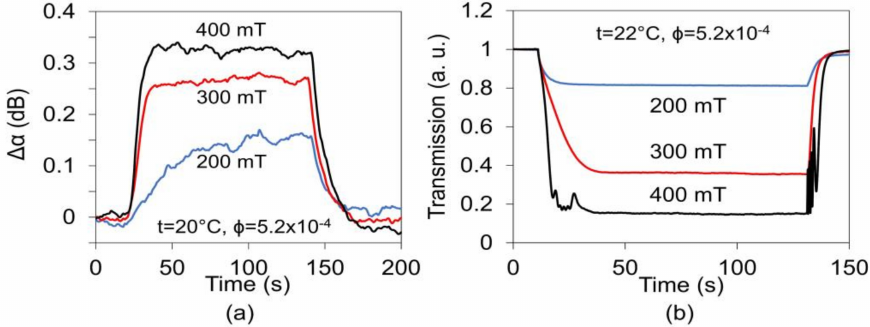
Figure 7. E ff ect of applied pulsed magnetic field (200, 300 and 400 mT) on SAW attenuation ( a ) and optical transmission ( b ) of 6CHBT doped with magnetic nanorods ( Φ = 5 × 10 − 4